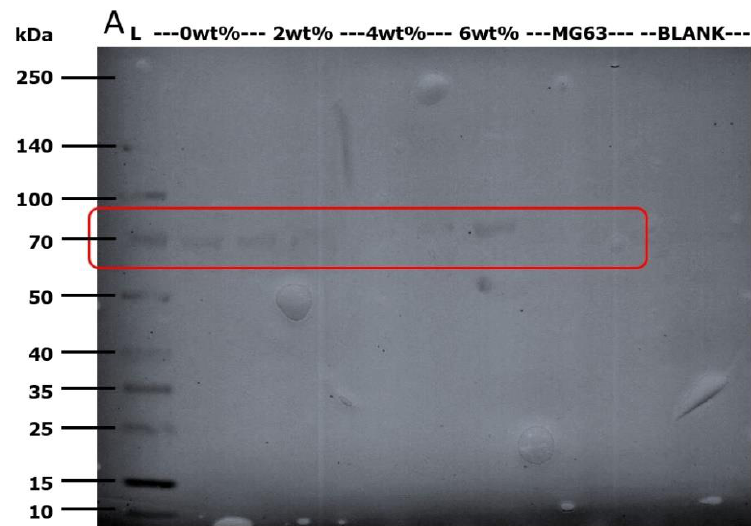
Figure 6. Nitrocellulose membrane from western immunodetection on 7th day post-incubation protein extract (A). The lanes starting from left indicate (L): the Multicolor Broad Range Protein Ladder (Fermentas). CS—2 lanes, CS-GO2—1 lane, CS-GO4—2 lanes, CS-GO6—1 lane, MG63 (control)—1 lanes and BLANK—2 lanes.